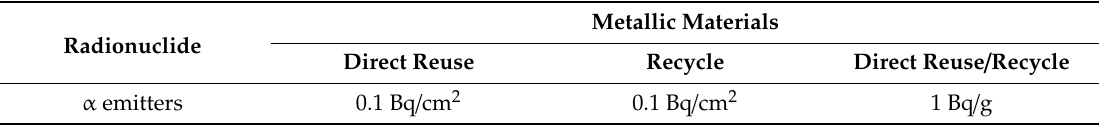
Table 2. Metallic materials clearance